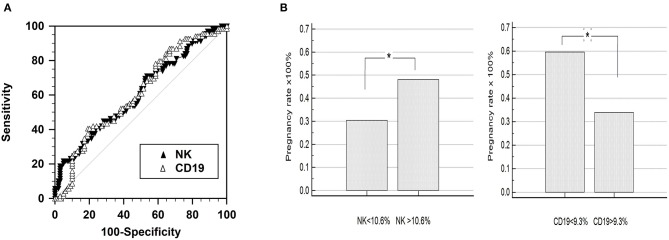
Receiver operating characteristic (ROC) curve analysis of CD56+CD16+ NK cell percentage. (A) Comparison of the predictive value for pregnancy outcome by means of area under the curve of receiver operating characteristic (ROCAUC) curve analysis. The percentage of peripheral natural killer (NK; CD56+CD16+) and B (CD19) cells featured similar ROCAUC for ART outcome. (B) Pregnancy outcome of the groups divided by the criteria selected by the ROC curve analysis: 10.6% for the NK cells (CD3-CD56+CD16+) and 9.3% for the B cells (CD19+), respectively.